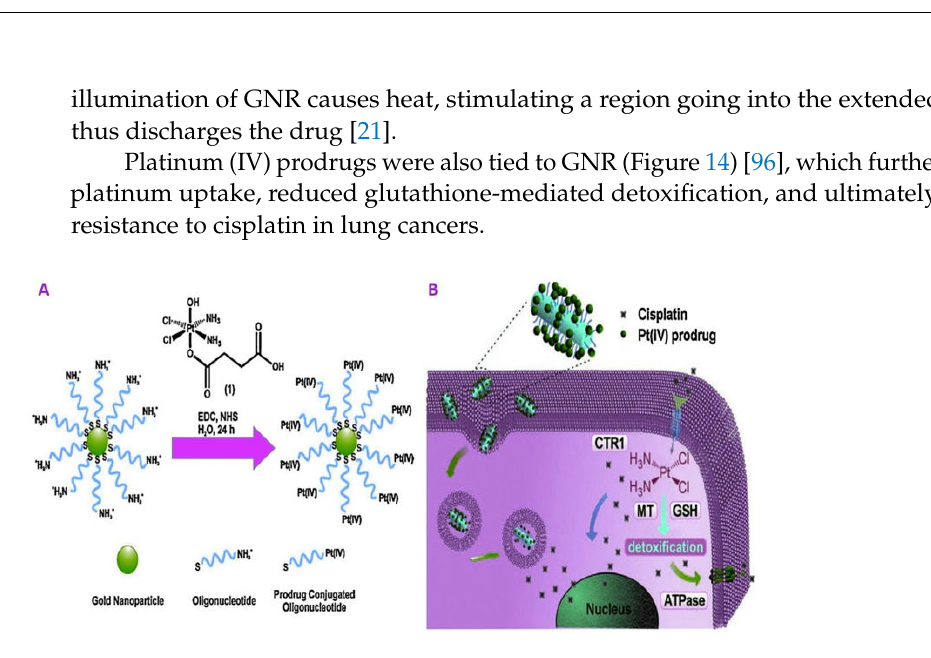
Figure 14. Gold nanoparticles and platinum (IV) nanorods for the delivery of drugs. The cisplatin platinum (IV) prodrug was conjugated through EDC/NHS coupling to gold nanoparticles ( A ) and nanorods ( B ) [97]. Reprinted with permission from ref. [97]. Copyright 2015 Materials